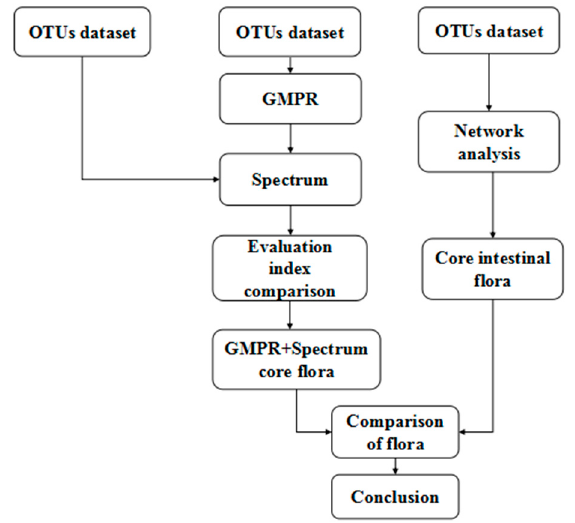
Figure 1. Schematic diagram of flora data processing in the paper.